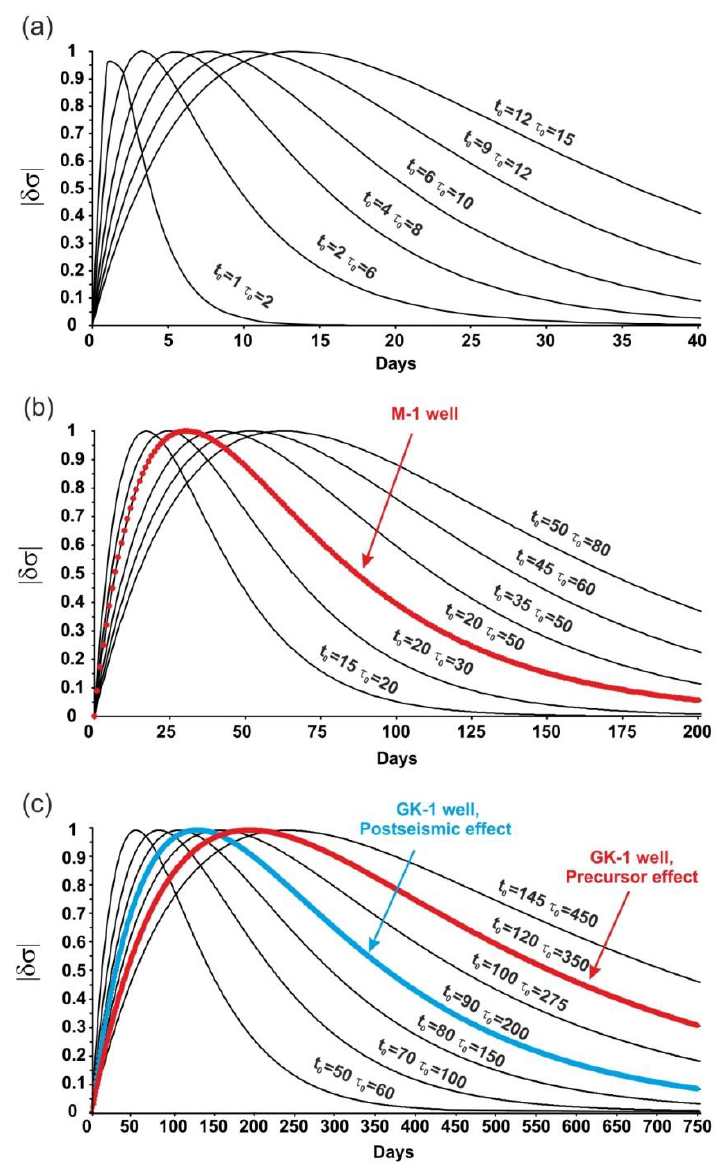
Figure 9. Calculated changes in concentration of the indicator component (IC) in underground outflowing water according to (3) at a relative value | δσ 0 | = 1 and different t 0 and τ 0 values: t 0 = 1–12 days, τ 0 = 2–15 days ( a ); t 0 = 15–50 days, τ 0 = 20–80 days ( b ); t 0 = 50–145 days, τ 0 = 60–450 days ( c ).